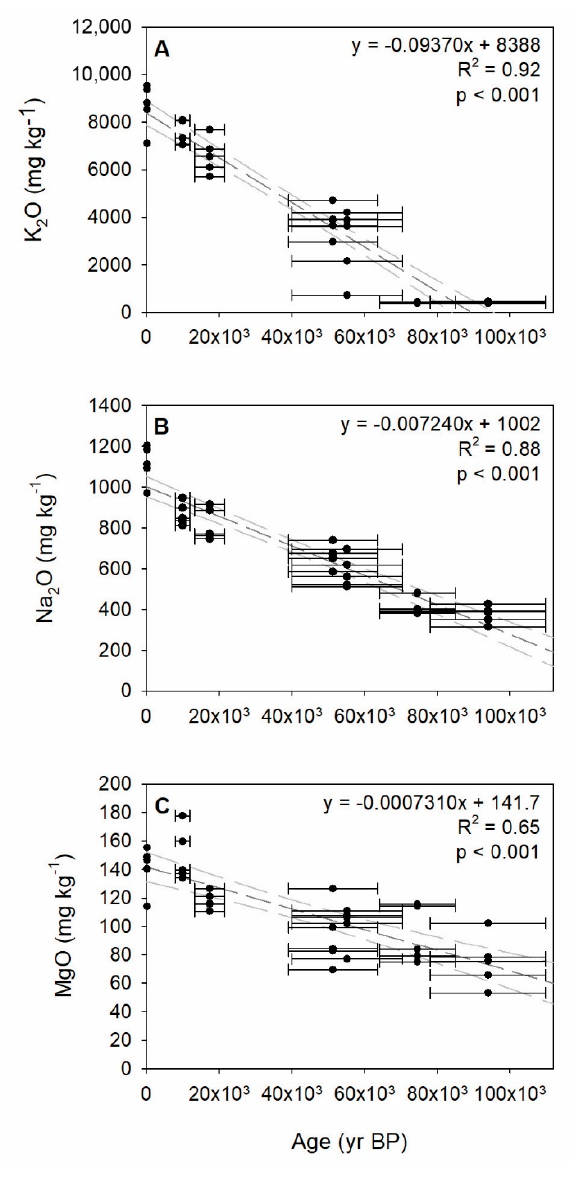
Figure 4. Chemical properties of the fine sand fraction (0.125–0.250 mm) plotted as a function of mean age. ( A ) K 2 O; ( B ) Na 2 O; ( C ) MgO. Data are from the most pedogenically well-expressed part of the subsoil and exclude measurements from modern channel alluvium. Results of linear regressions are shown for each parameter. p -values apply to the significance level of the F-ratio of regressions, and gray dashed lines depict 95% confidence intervals. Error bars represent two standard deviations of the OSL age estimates.